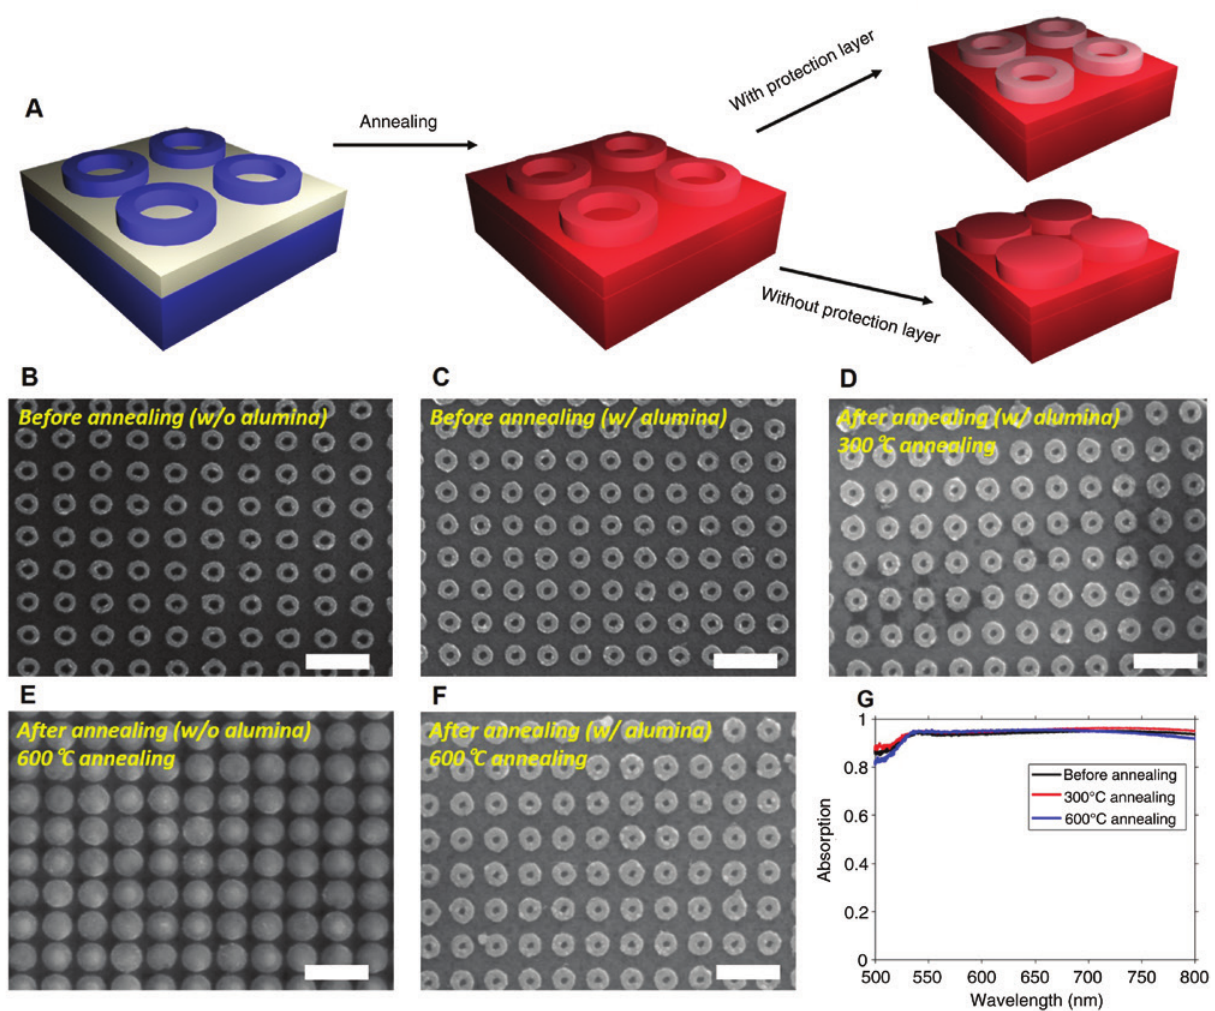
Figure 5: Thermal stability characterizations. (A) Alumina protection layer coating to improve the heat resistance of the devices. Atomic layer deposition was used and Cr ring structures were perfectly sealed. (B) SEM image of Cr absorber without alumina protective layer before annealing. (C) SEM image of Cr absorber with alumina protection layer before annealing (D) SEM image of Cr absorber with protection layer after annealing at 300 ° C. (E) SEM image of Cr absorber without protection layer after annealing at 600 ° C. (F) SEM image of Cr absorber with protection layer after annealing at 600 ° C. Scale bar, 500 nm. (G) Absorption spectra of Cr absorber coated with 4-nm-thick alumina before and after annealing at 300 ° C or 600 °